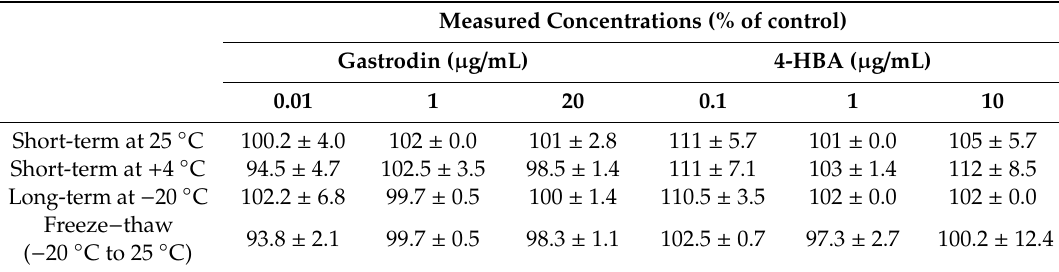
Table 2. Stability of gastrodin and 4-HBA in rat plasma stored under ambient